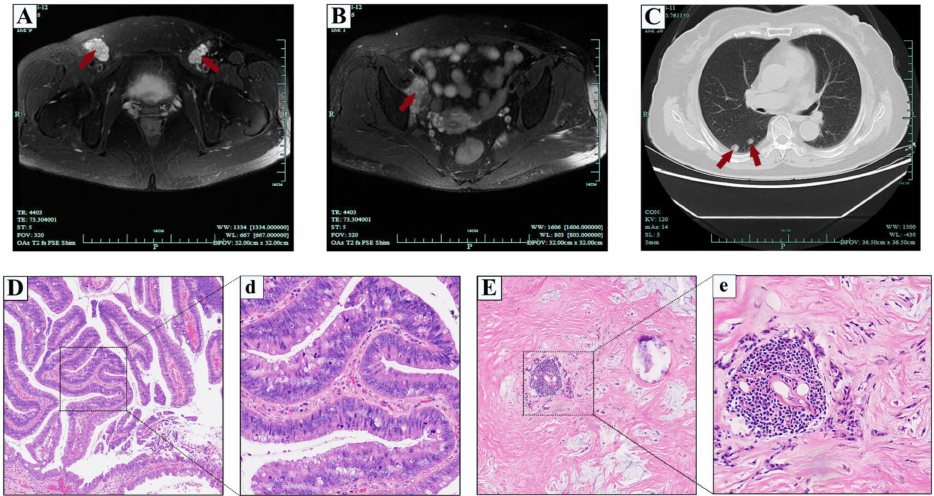
Figure 4. Imaging examinations and histopathologic features of the Case 2 in 2020. ( A ) Enlarged lymph nodes with marked enhancement were seen in the bilateral inguinal regions. ( B ) An abnormal mass signal shadow with approximate dimensions of 3.4 × 2.0 cm in the right iliopsoas muscle, with equal signal in T1- weighted images and higher in T2- and even enhancement after contrast administration. ( C ) Pulmonary CT scan indicated multiple high-density nodules in both lungs, which were considered metastatic nodules first. (Red arrows indicate the corresponding foci). H&E staining of low-power (4 × 10 magnification) and high-power (40 × 10 magnification) view showing the metastatic mucinous adenocarcinoma were present in the bilateral inguinal lymph nodes ( D , d ) and right iliopsoas mass ( E , e